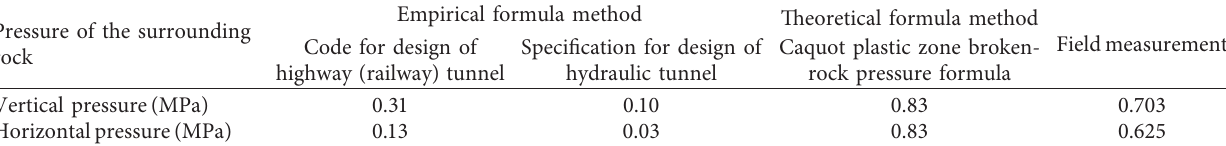
Table 3: Results of comprehensive comparative